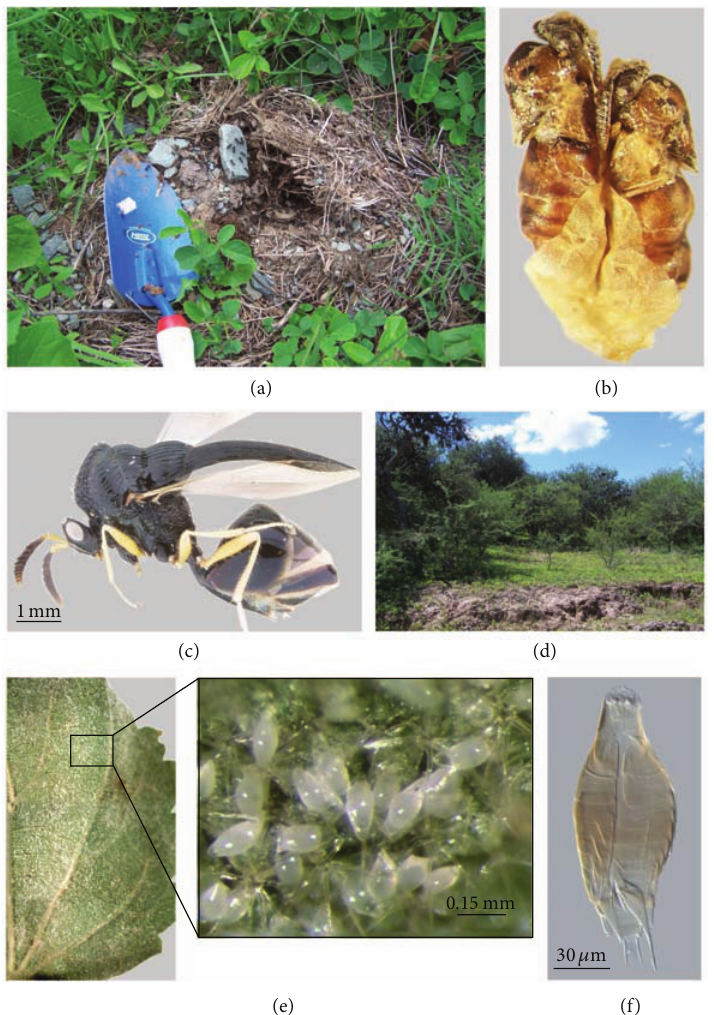
Figure 6: Biology and immature stage of Lophyrocera variabilis : (a) ant nest of Camponotus sp.; (b) two Lophyrocera pupae extract from same ant cocoon (females). Neolirata alta : (c) habitus (female). Biology and immature stage of N. alta : (d) habitat; (e) underside of leaf of P. virgatum with eggs (magnified area with eggs); (f) planidia. Figure 6(b) is extracted from [26], and Figures 6(c), 6(d), 6(e), and 6(f) are extracted from